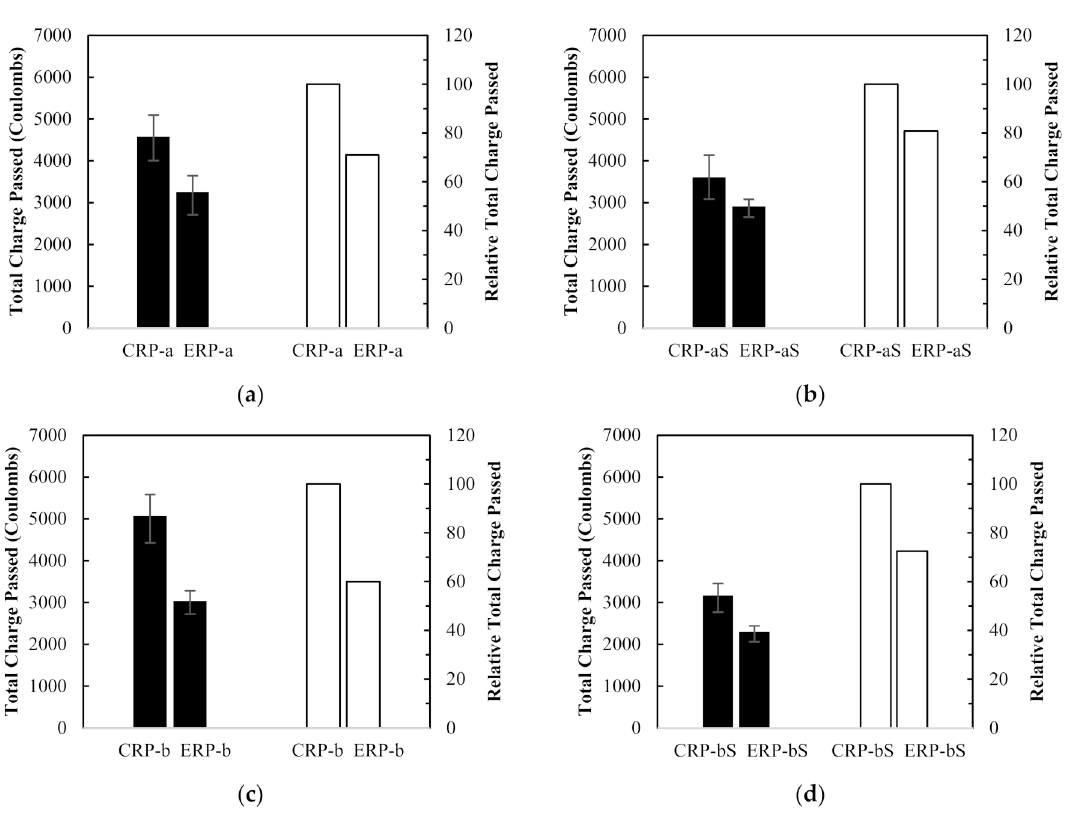
Figure 13. Rapid Chloride Penetration Test results and relative values between different mix design method: ( a ) CRP-a, ( b ) CRP-aS, ( c ) CRP-b, and ( d )